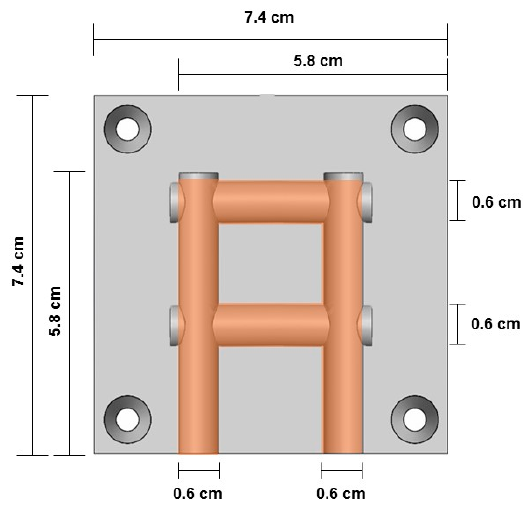
Figure 2. Sectional diagram of the water block.